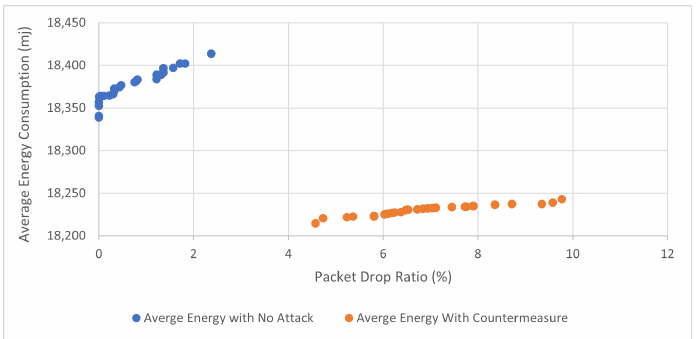
Figure 20. Correlation of throughput and average energy consumption.